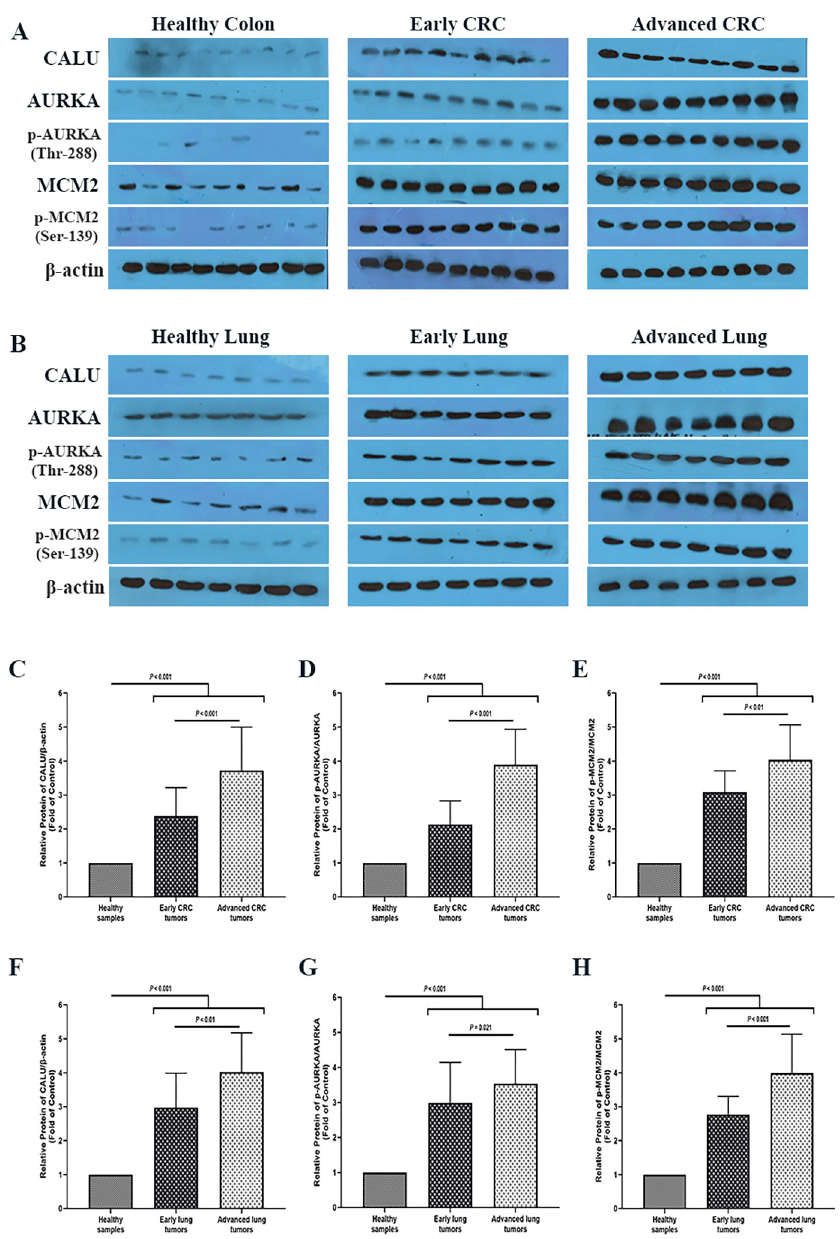
Fig 8. A nalysis of CALU, AURKA, and MCM2 proteins level in biopsy specimens and matched adjacent healthy tissues collected from (A) CRC and (B) lung cancer patients. (C) Comparative analysis of CALU level between healthy samples, early and advanced CRC tumors. (D) Comparative analysis of p-AURKA/AURKA ratio between healthy samples, early and advanced CRC tumors. (E) Comparative analysis of the p-MCM2/MCM2 ratio between healthy samples, early and advanced CRC tumors. (F) Comparative analysis of CALU level between healthy samples, early and advanced lung tumors. (G) Comparative analysis of p-AURKA/ AURKA ratio between healthy samples, early and advanced lung tumors. (H) Comparative analysis of the p-MCM2/ MCM2 ratio between healthy samples, early and advanced lung tumors. Western blot analysis was performed with a 1:1000 dilution of the anti-CALU antibody, anti- Aurora A antibody, anti-Phospho-Aurora A (Thr288) antibody, anti-MCM2 antibody, and anti-Phospho-MCM2 (Ser139) antibody. The quality of protein bands was measured with the NIH ImageJ software relative to the control band (B-actin). Each value is the mean ± SD of six separate experiments. The asterisk indicates significantly different from the control group.